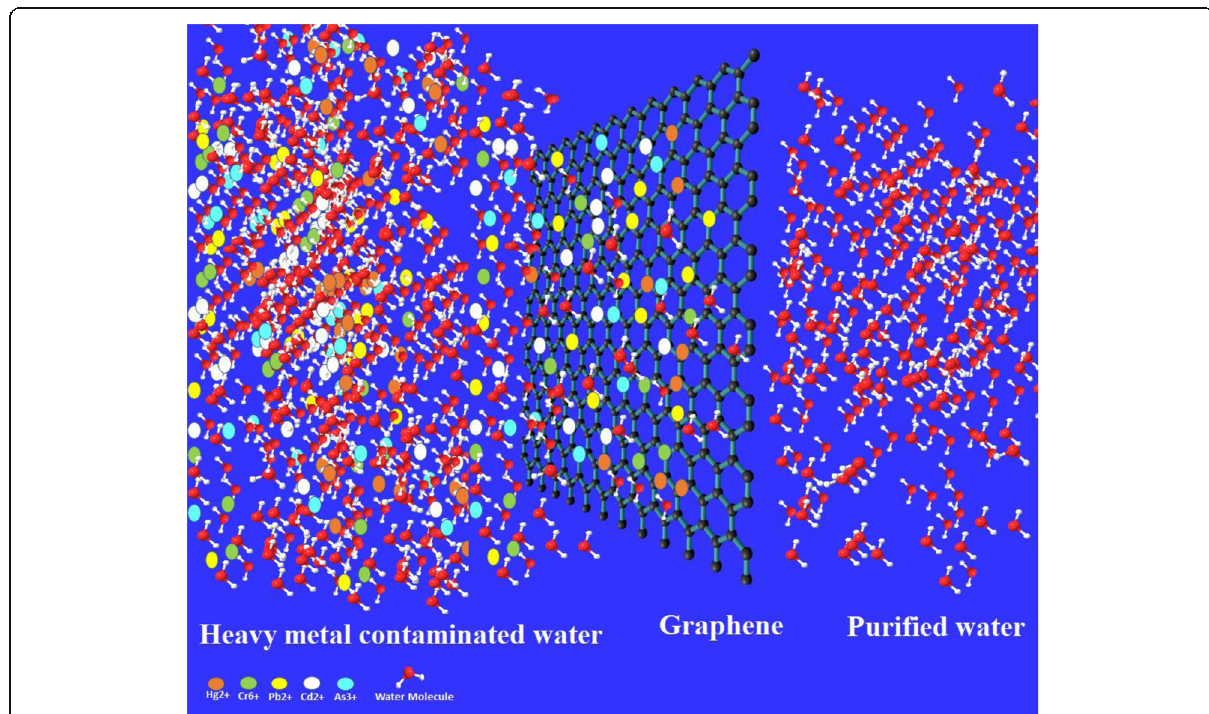
Fig. 1 Graphical abstract showing that the heavy metal-contaminated water purification process using graphene and other carbon-based materials can also do the